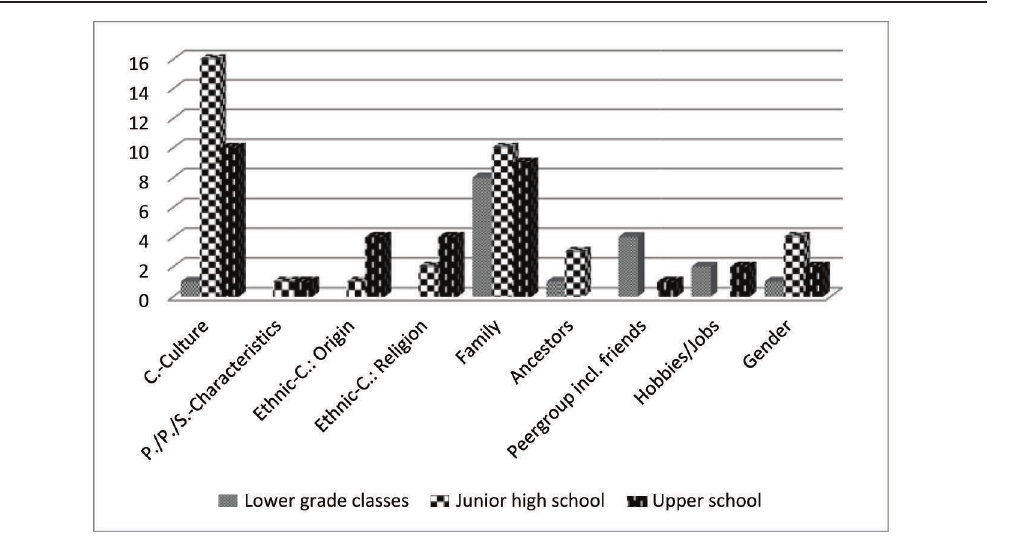
Figure 3: Subject references in relation to class